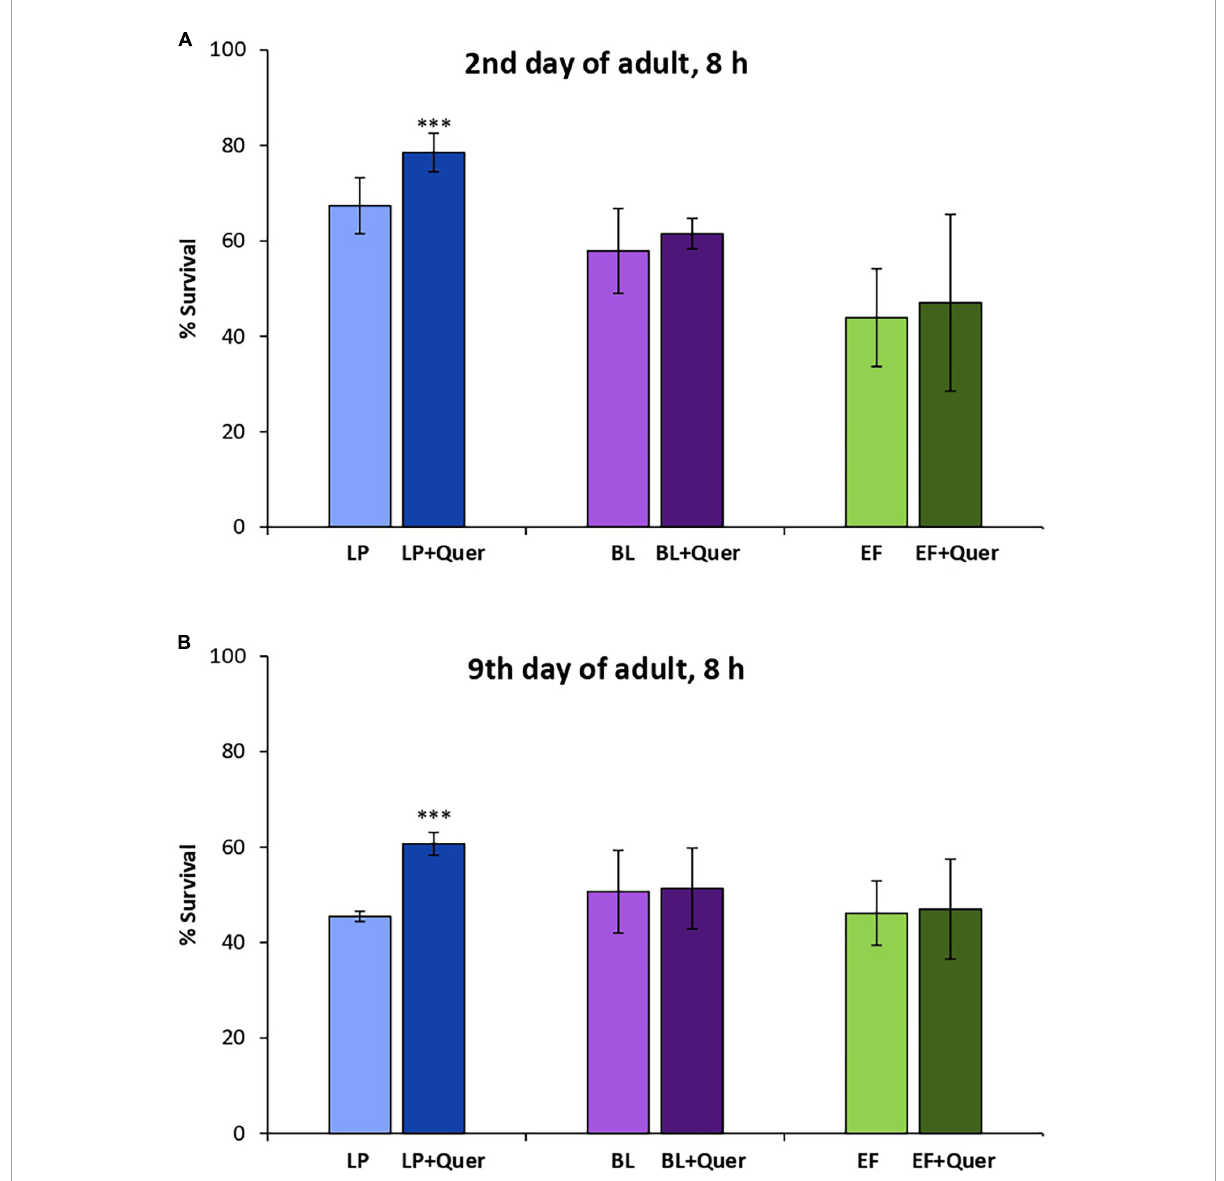
FIGURE5 Survival rates of N2 wild type C. elegans after being submitted to thermal stress (35 ◦ C, 8 h) applied at days 2 (A) and 9 of adulthood (B) following cultivation with and without quercetin (Quer, 200 µ M) in the presence of Lactobacillus plantarum CLC17 (LP), Bifidobacterium longum NCIMB 8809 (BL) or Enterococcus faecium CECT 410 (EF). Differences between worms grown without and with Quer were calculated for each strain using the Chi-Square Test. The differences were considered significant at *** p <